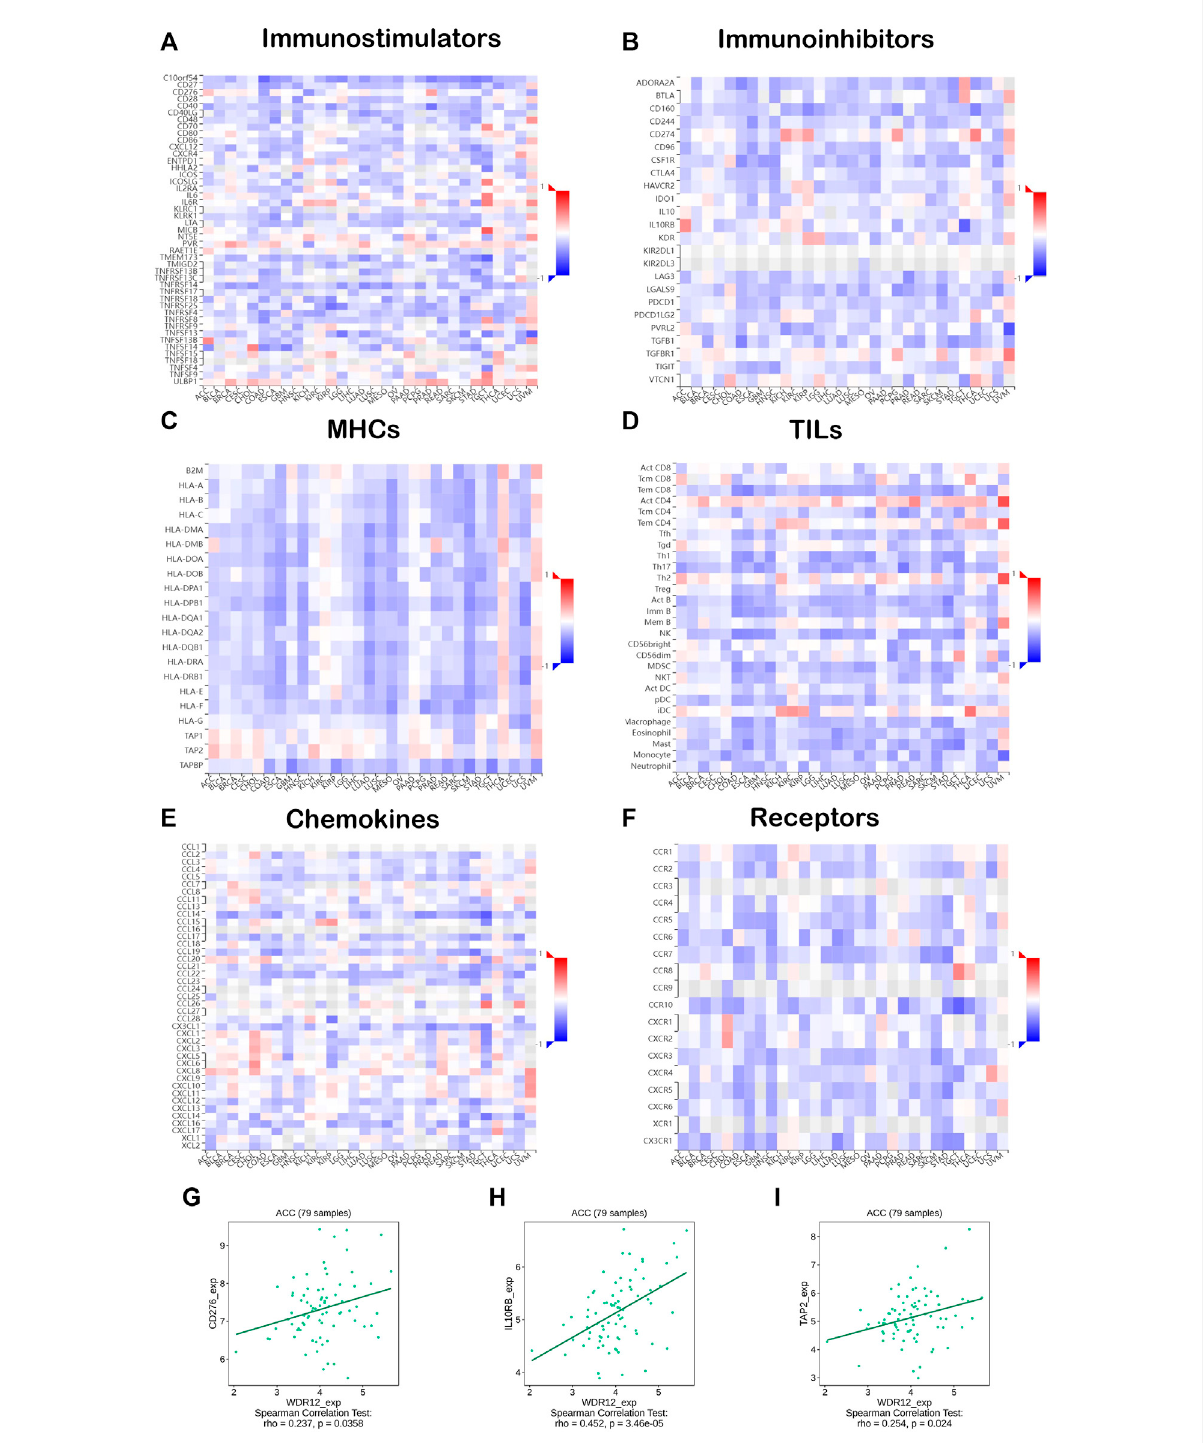
FIGURE 8 Correlation analysis of WDR12 expression with immunoregulators. Heatmaps correlating WDR12 with (A) Immunostimulators; (B) Immunoinhibitors; (C) MHCs; (D) TILs; (E) Chemokines; (F) Receptors. Plots (G – I) show the correlation between WDR12 and CD276, IL10RB, and TAP2,